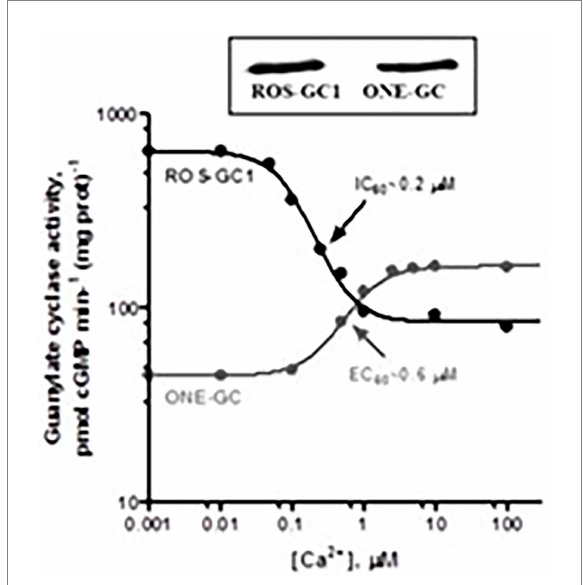
FIGURE 10 Antithetical Ca 2+ modulation of ROS-GC1 and olfactory neuroepithelial guanylate cyclase (ONE-GC) activities by GCAP1. In the presence of GCAP1, the catalytic activity of recombinant ROS-GC1 decreases as Ca 2+ is raised from 1 nM to100 mM, but the catalytic activity of recombinant ONE-GC increases. Western blots confirming ROS-GC1 and ONE-GC expression are shown above. Redrawn from Duda et al.